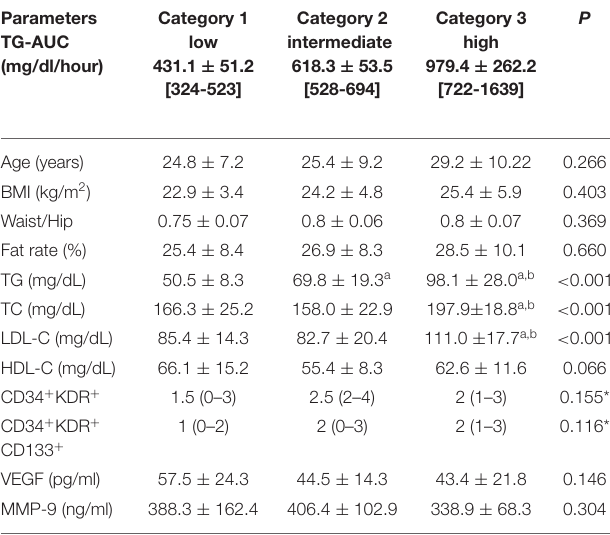
TABLE 2 | Physical characteristics and biochemical and immunological parameters in women according to the three categories of TG-AUC ( n = 14), mean ± SD